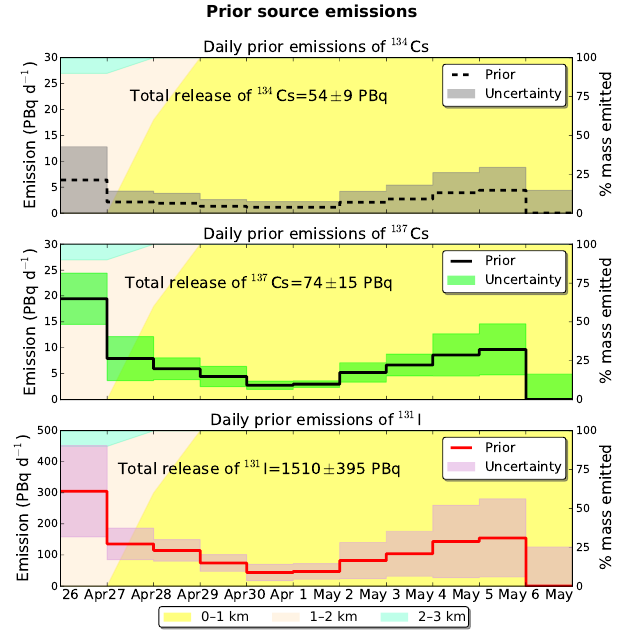
Figure 2. Calculated prior source term and uncertainty for 134 Cs (black dashed line), 137 Cs (black line) and 131 I (red line) from 26 April to 7 May 1986. Note that emissions are plotted only until 6 May for simplicity, as on 6 and 7 May 1986 they were reported to be zero. The prior releases were calculated as the average and stan- dard deviation of the six previously published source terms (prior 1–6) shown in Fig. 1. On the right axis the vertical distribution of the emissions at altitudes 0–1km (yellow), 1–2km (beige) and 2– 3km (turquoise) is plotted as shaded background